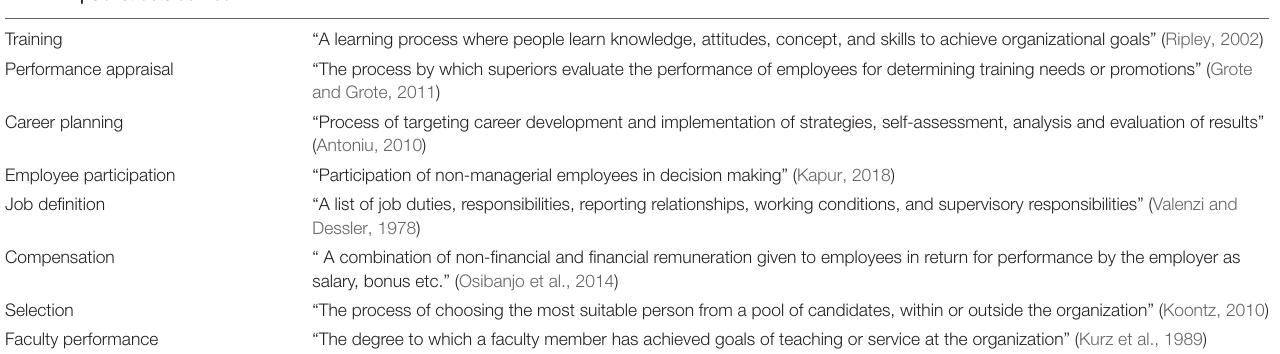
TABLE 1 | Constructs